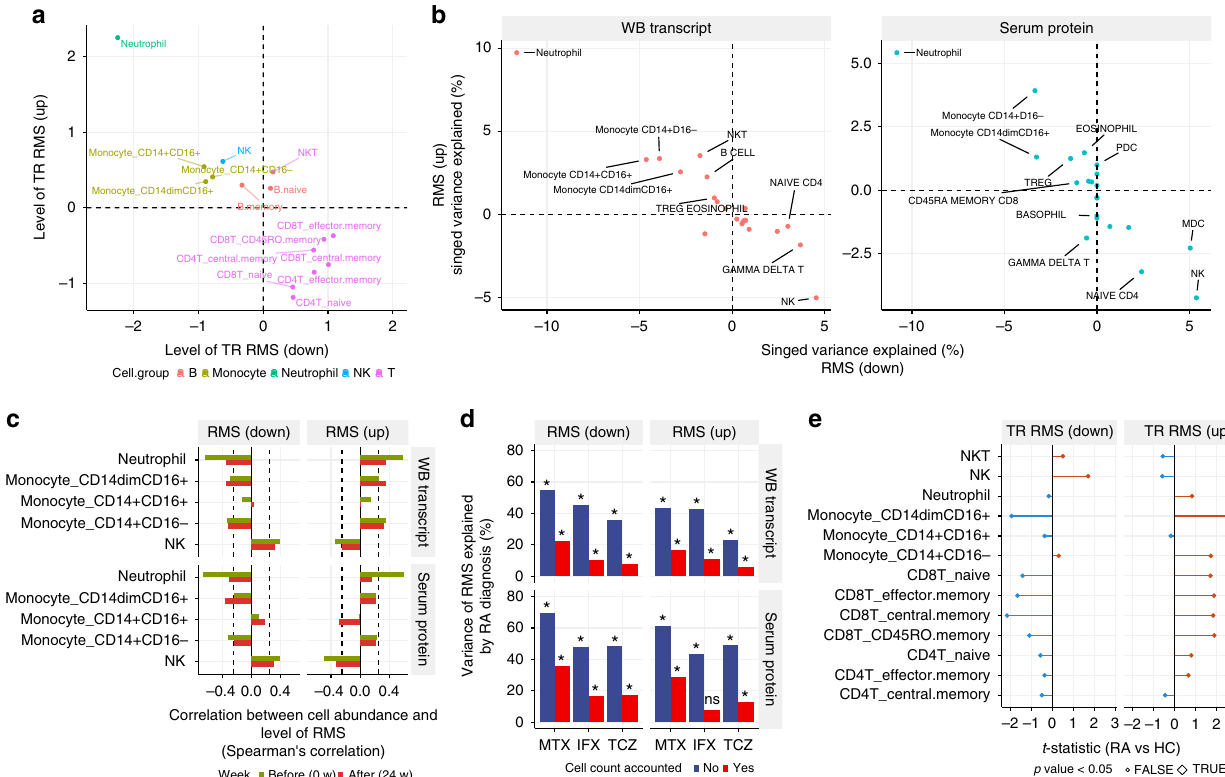
Fig. 5 Alterations in cell compositions and cellular-level expression explain RMS. a Expression pro fi les of transcriptional RMSs across 15 immune cells. Meta-expression features for the transcriptional RMS that were upregulated or downregulated in RA were calculated separately using the ssGSEA method and standardized across immune cells. b The contribution of cell abundance to RMSs. Multivariate linear regression with elastic net regularization was used to estimate the variations in RMSs explained by the absolute cell counts using samples from HCs and drug responders ( n = 182). c Correlation between RMSs and cell counts of neutrophil, monocytes, and NK cells. d The variance in RMS explained by RA diagnosis. The proportion of variance in RMS explained by RA diagnosis was calculated with or without accounting for the contribution of cell counts to RMS. The contribution of cell counts to RMS was accounted for by a multivariate linear regression. The asterisk represents a p value <0.05. e Comparison of transcriptional RMSs between patients with RA and HCs in puri fi ed immune cells. The levels of transcriptional RMSs in each immune cell were quanti fi ed using ssGSEA and compared between RA patients and HCs via a linear model for each cell